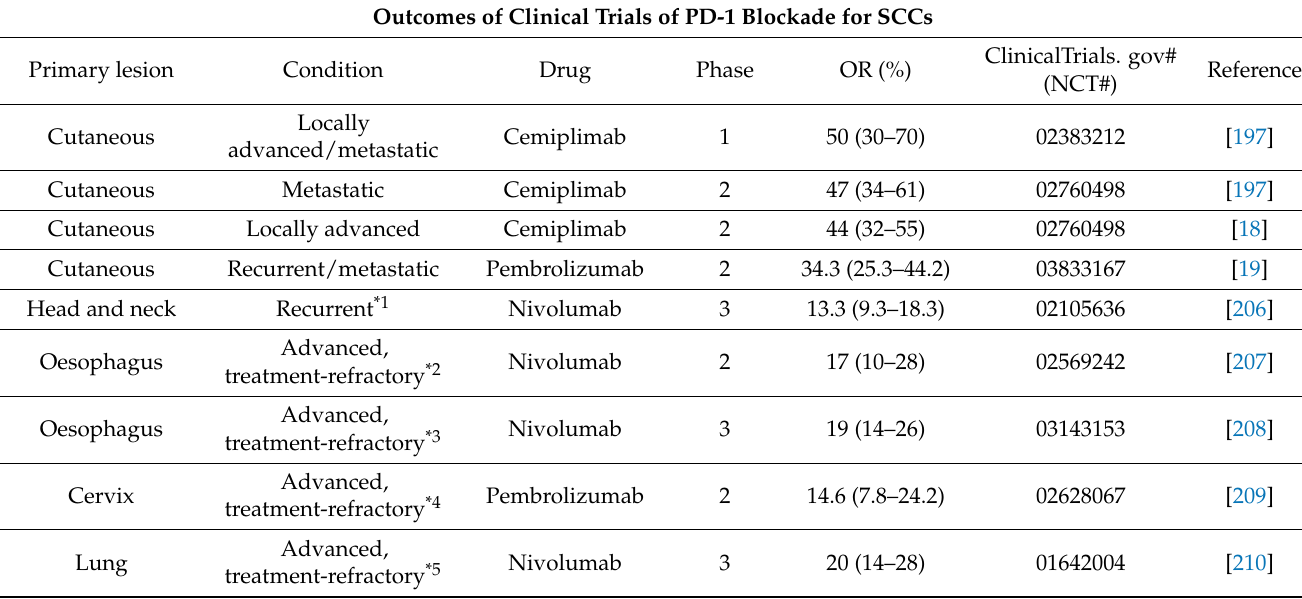
Table 6. The outcomes of clinical trials of programmed death-1 (PD-1) blockade for squamous cell carcinomas (SCCs). Outcomes of Clinical Trials of PD-1 Blockade for